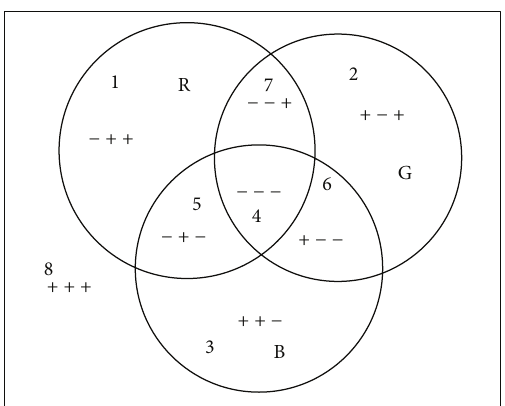
Figure 2: Image for illustrating the MSC method.